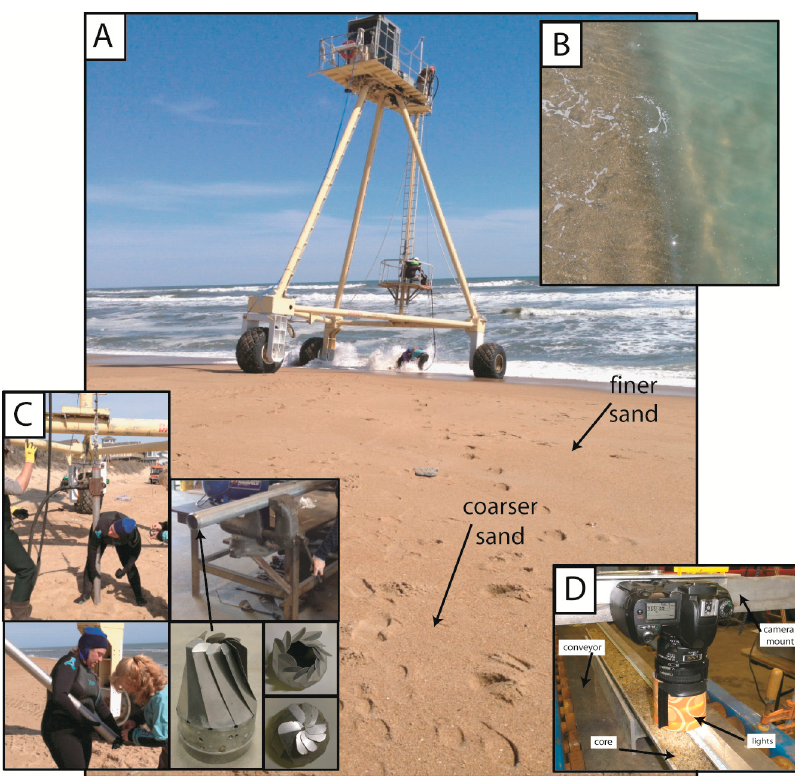
Figure 2. Various images from the experiment including: ( A ) sampling from the DI in the swash; ( B ) close ‐ up of the coarse ‐ gravel step at the base of the swash zone; ( C ) coring and core catchers; and ( D ) DIS camera mounted above the conveyor belt with a core beneath it.